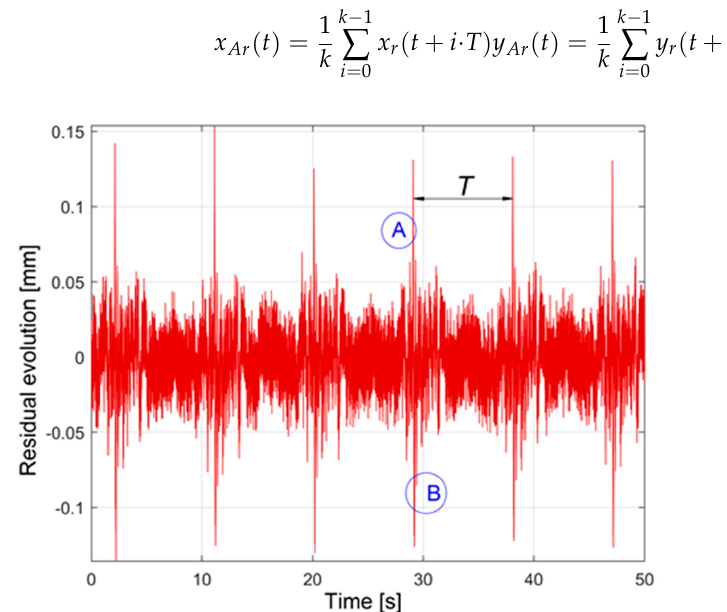
Figure 7. The evolution of residual y r from the harmonic fitting model for y -motion.